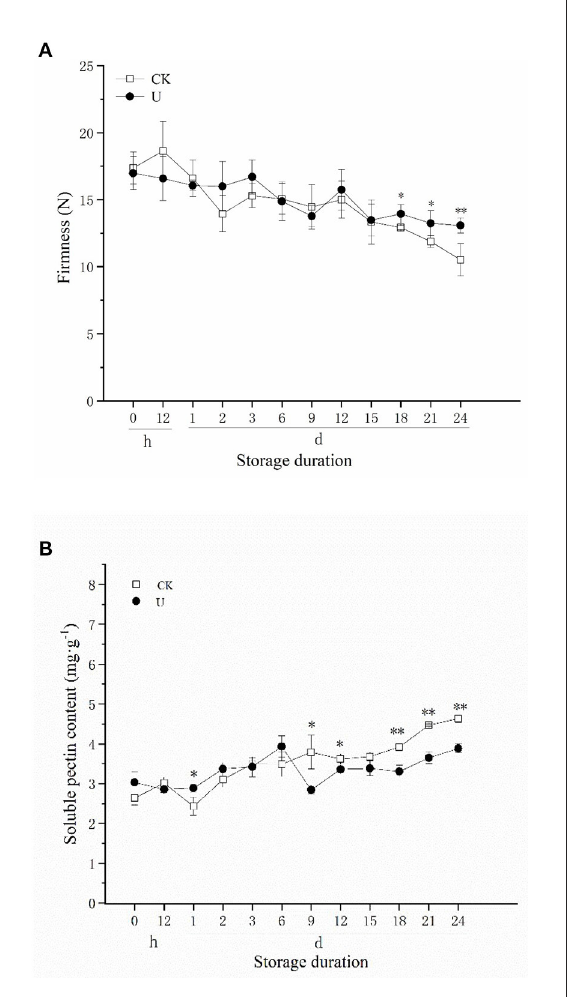
FIGURE2 Effect of ultrasound on firmness (A) and soluble pectin (SP) content (B) in strawberries during storage. Data represent the means ± SE, n = 3. According to independent t -tests, asterisks indicate significant difference (* P < 0.05, ** P < 0.01) between CK and U treatments at the same time